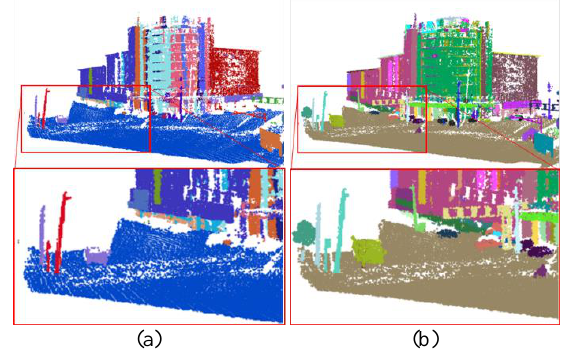
Figure 7. An experiment on vehicle borne LiDAR data. (a) The result of octree-based region growing method (Vo et al., 2015); (b) the result of the proposed